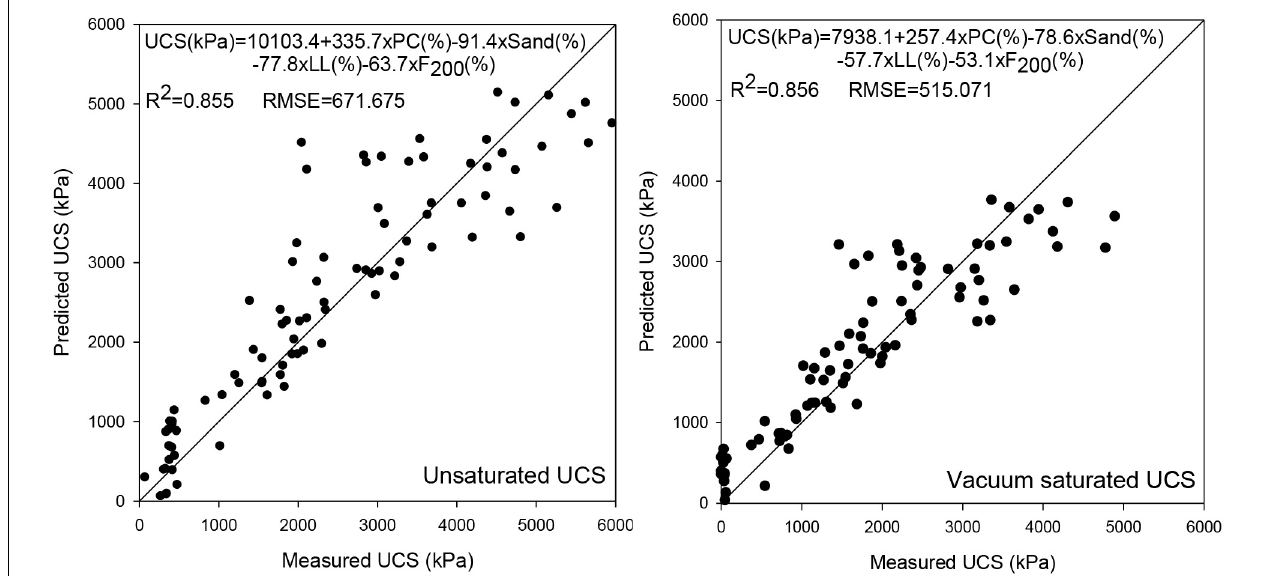
FIGURE 7 | Comparison of the measured and predicted UCS of unsaturated and vacuum saturated